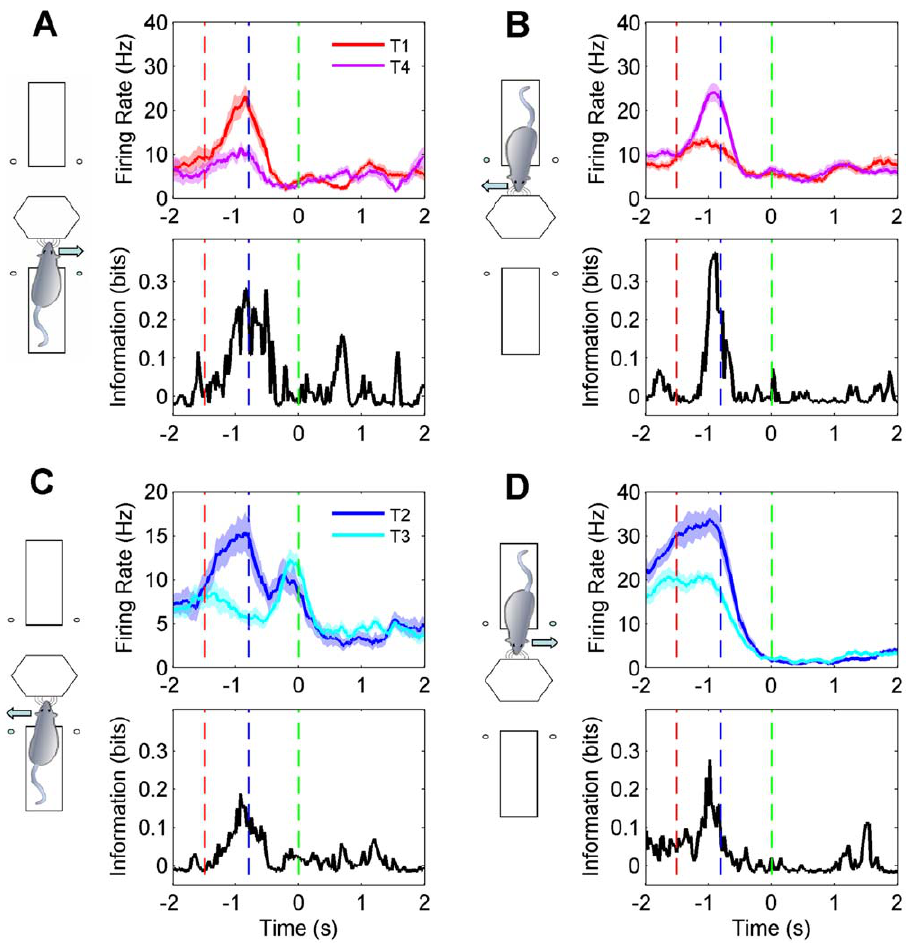
Figure 3. Texture signals in the two-platform task. For each of four neurons (A–D), responses are shown for the only pair of stimuli for which the value of texture information was statistically significant (p , 0.05). The icon to the left of each plot shows the platform occupied by the rat and the action (arrows: turn left or turn right) associated with the two textures. In each panel, the upper plot shows time-varying firing rate related to the two textures. Shaded area corresponds to standard error of the mean. The lower plot shows the temporal profile of information about texture identity carried by neuronal firing rate. Red, blue, and green dashed lines indicate the estimated start of time windows during which rats engaged in touch, turn and reward collection.